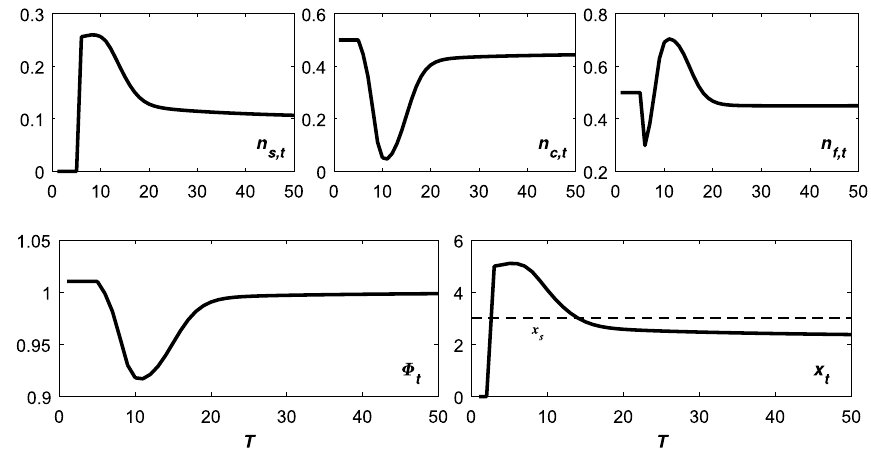
Fig. 9 Dynamic response to a positive shock based on HAM3: